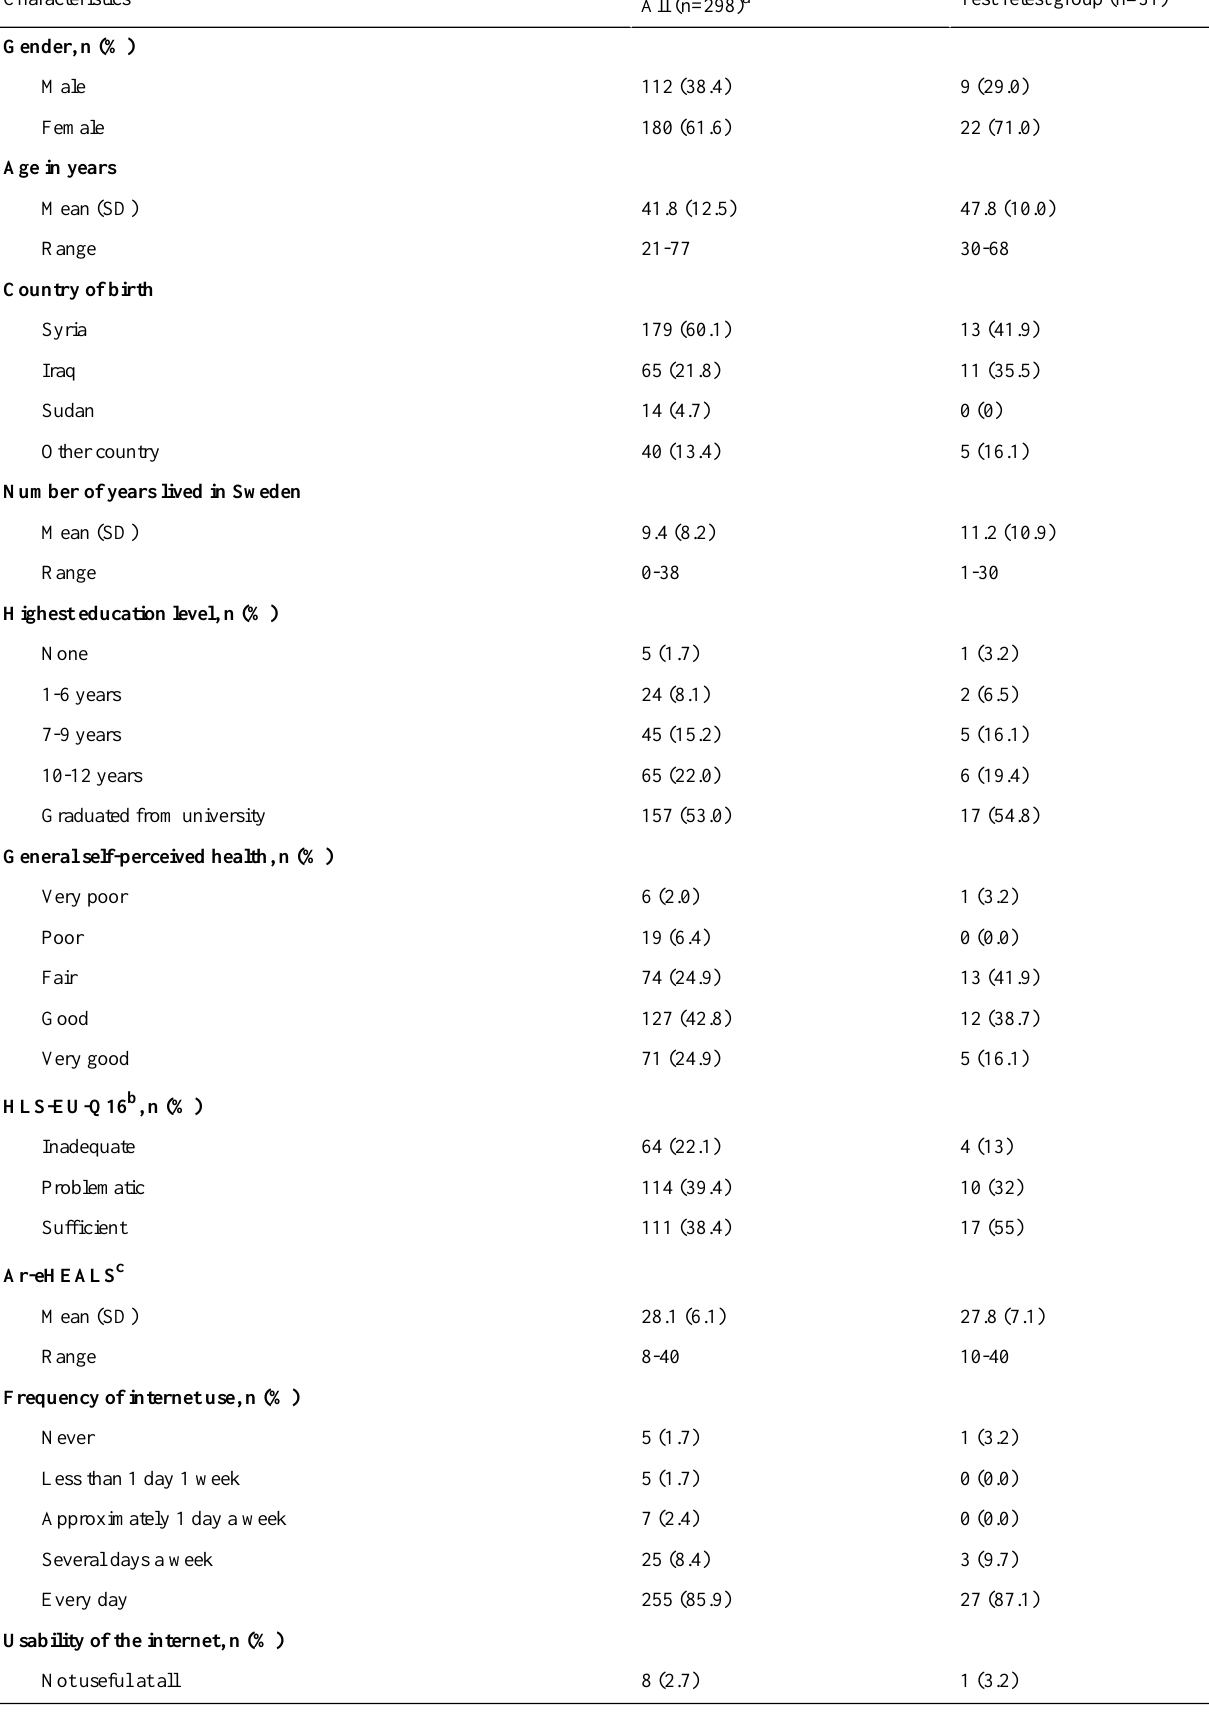
Table 2. Demographics of the respondents with a valid eHEALS sum score and the test-retest